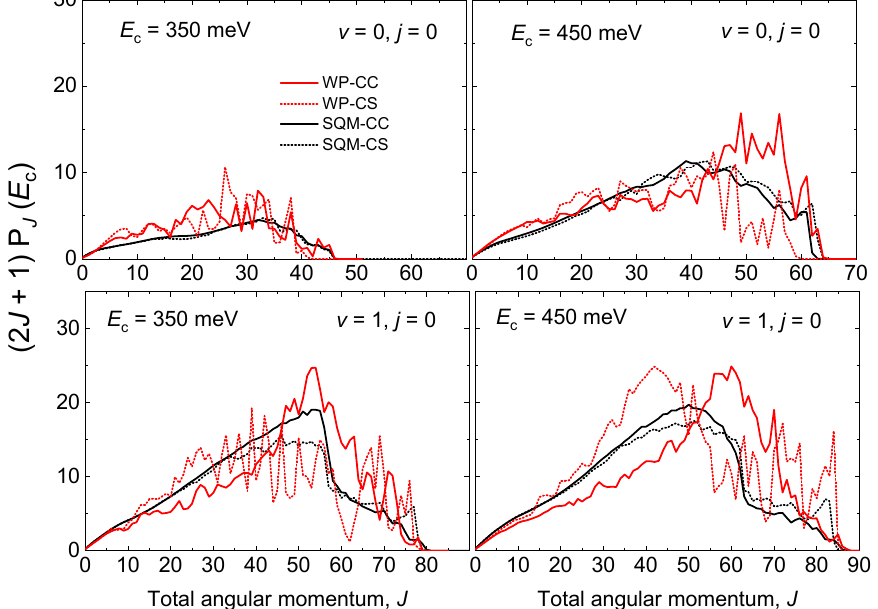
Figure 7. Opacity functions as ( 2 J + 1 ) P ( J ) for the He + NeH + ( v , j ) reaction for v = 0, j = 0 ( top panels ) and v = 1, j = 0 ( bottom panels ) at two different values of the collision energy E c = 350 meV ( left panels ) and E c = 450 meV ( right panels ) as a function of the total angular momentum J . WP results (red lines) and SQM (black line) within the coupled-channel (solid line) and close-coupling schemes (dotted line) adapted from Reference [53] are